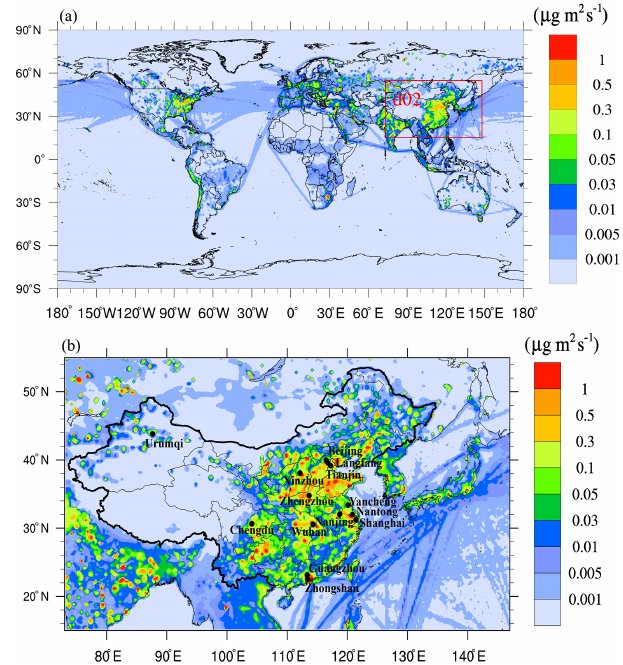
Figure 1. The simulation domain showing the total SO 2 emissions (µgm − 2 s − 1 ). (a) Domain 1, with the position of domain 2 shown using the red square. (b) Domain 2, black circles are locations of the city sites in the domain